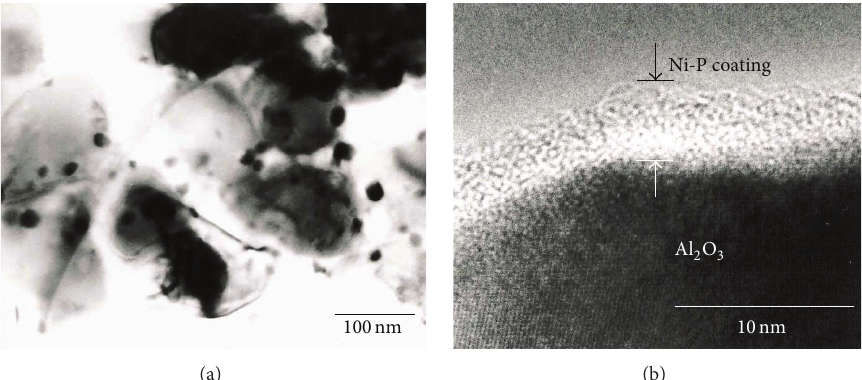
Figure 3: TEM (a) and HRTEM (b) of images of the Al 2 O 3 -10wt.% Ni-P powders synthesized by Ni-P electroless deposition process.